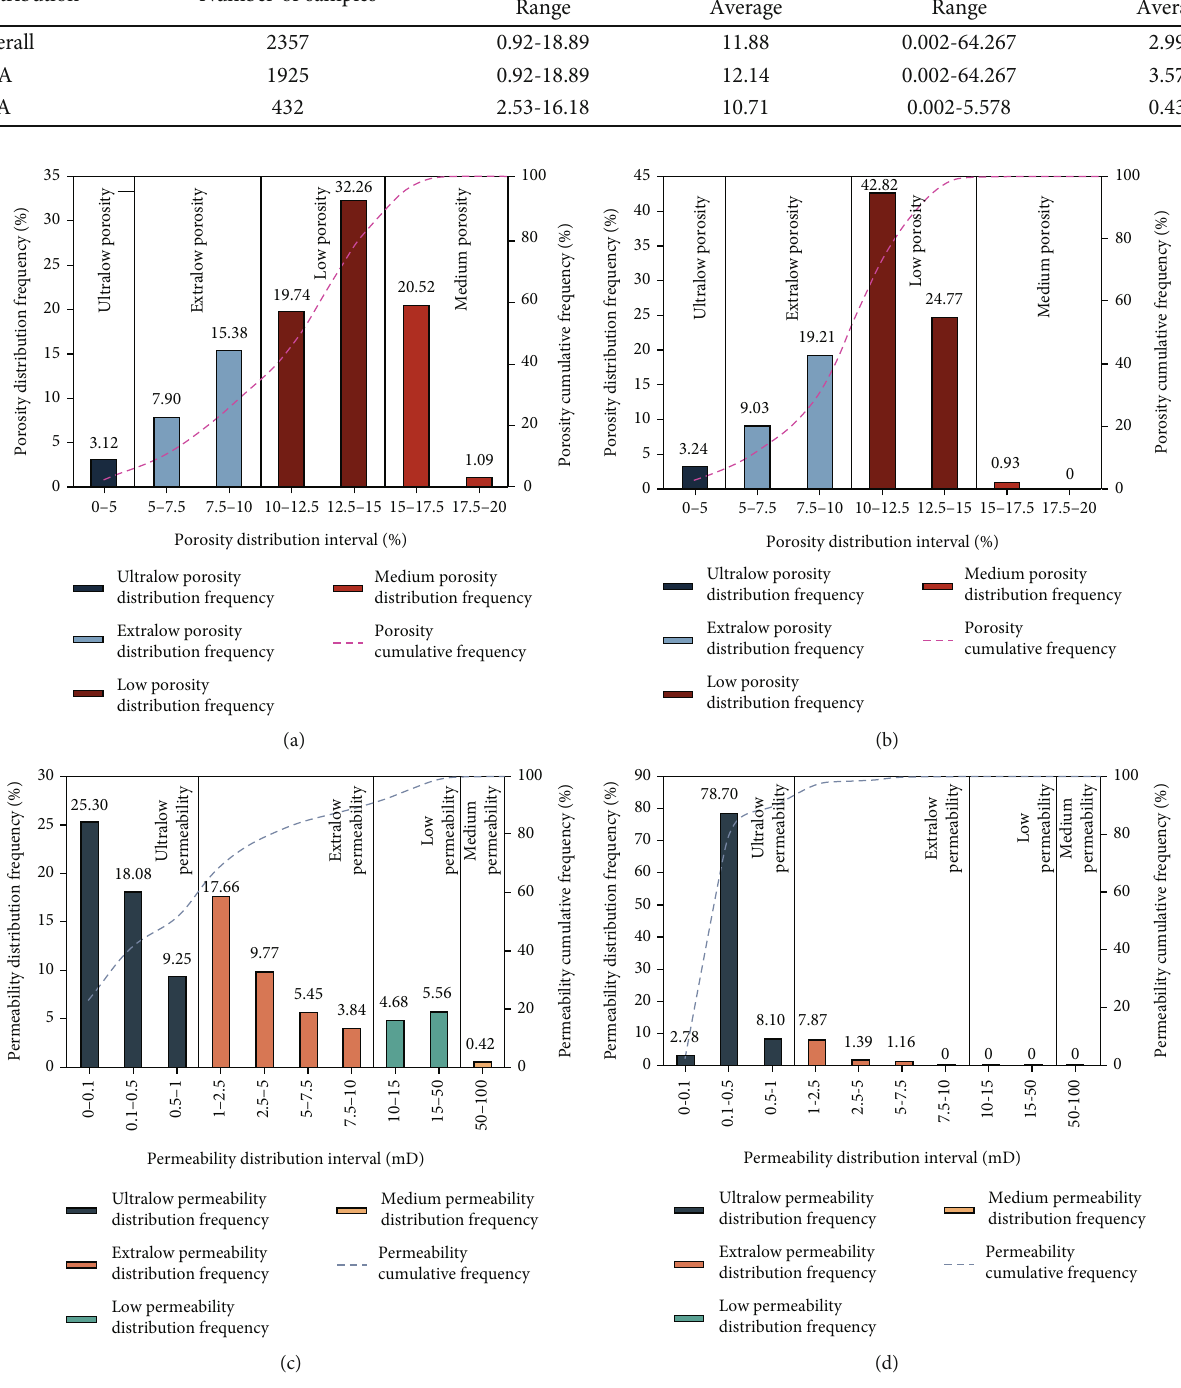
Figure 6: Distribution characteristics of core properties in the YPA and APA of the Chang 8